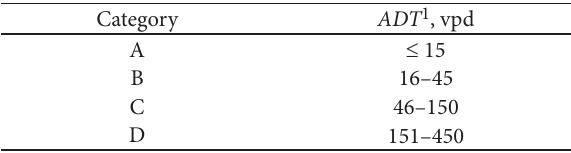
Table 3 . Classification of low-volume roads according to ADT